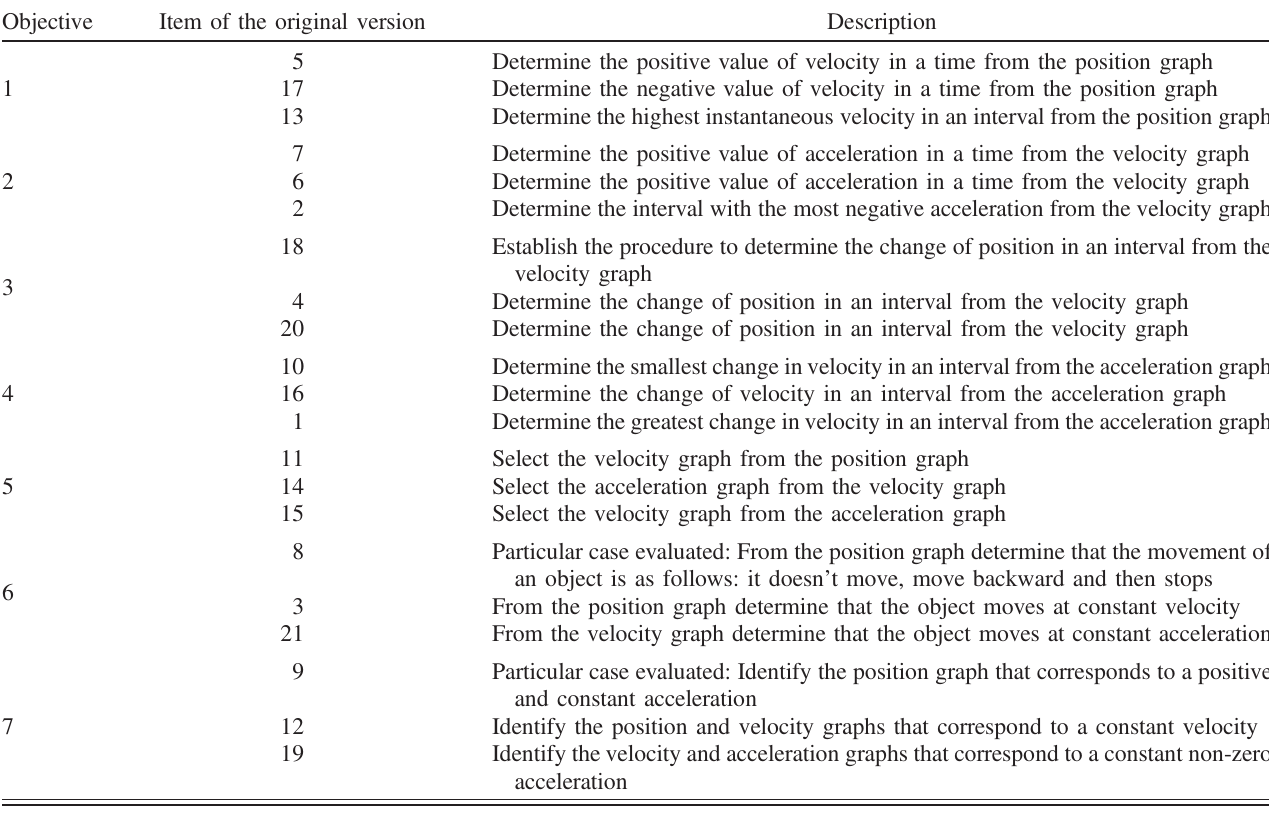
TABLE II. Description of the 21 items of the original version grouped by each of the 7 objectives.